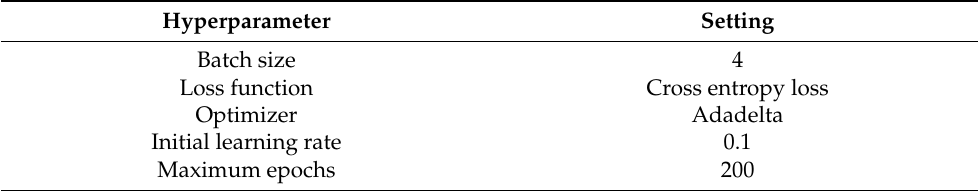
Table 1. Details of hyperparameter settings.